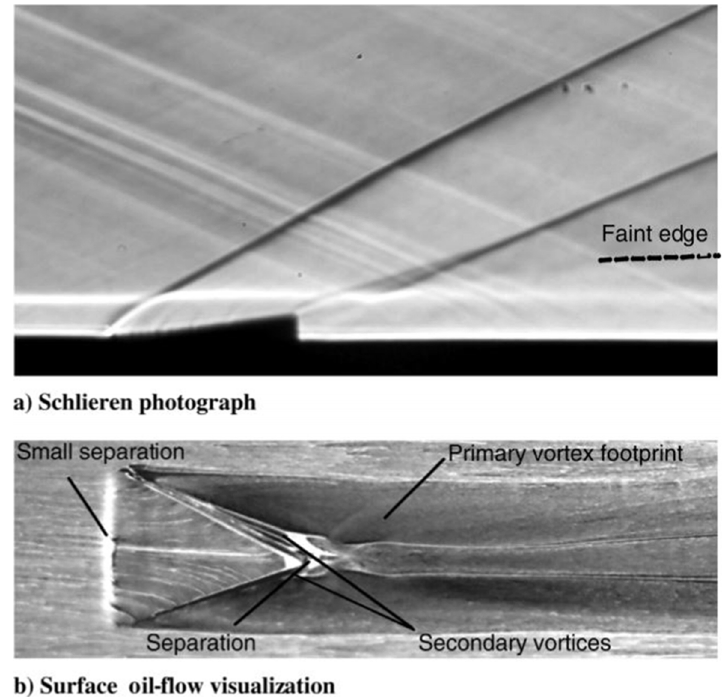
Fig. 12 Flow visualization with the microramp of 4 mm height [140]